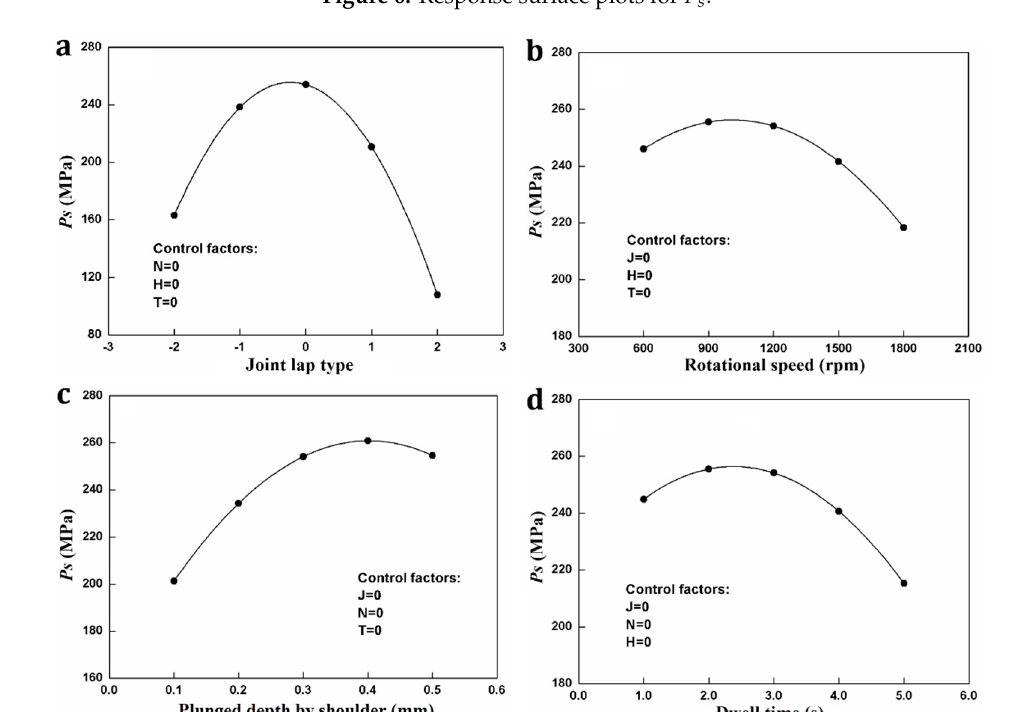
Figure 6. Response surface plots for P s . Metals 2019 , 9 , x FOR PEER REVIEW